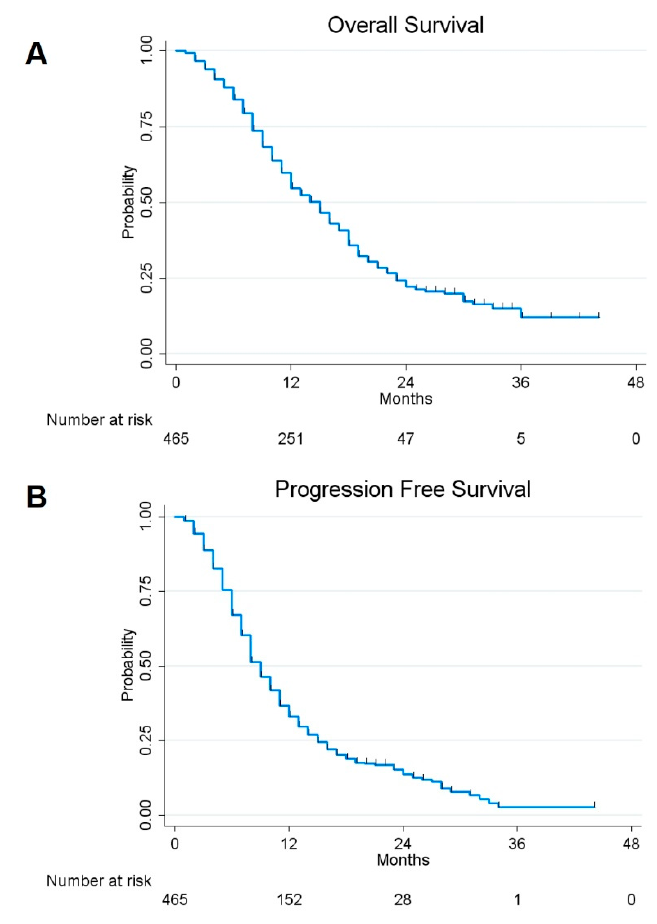
Figure 1. Kaplan–Meier curves displaying overall survival (OS) ( A ) and progression-free survival (PFS) ( B ) in the whole sample of 465 glioblastoma (GBM) included in the study.